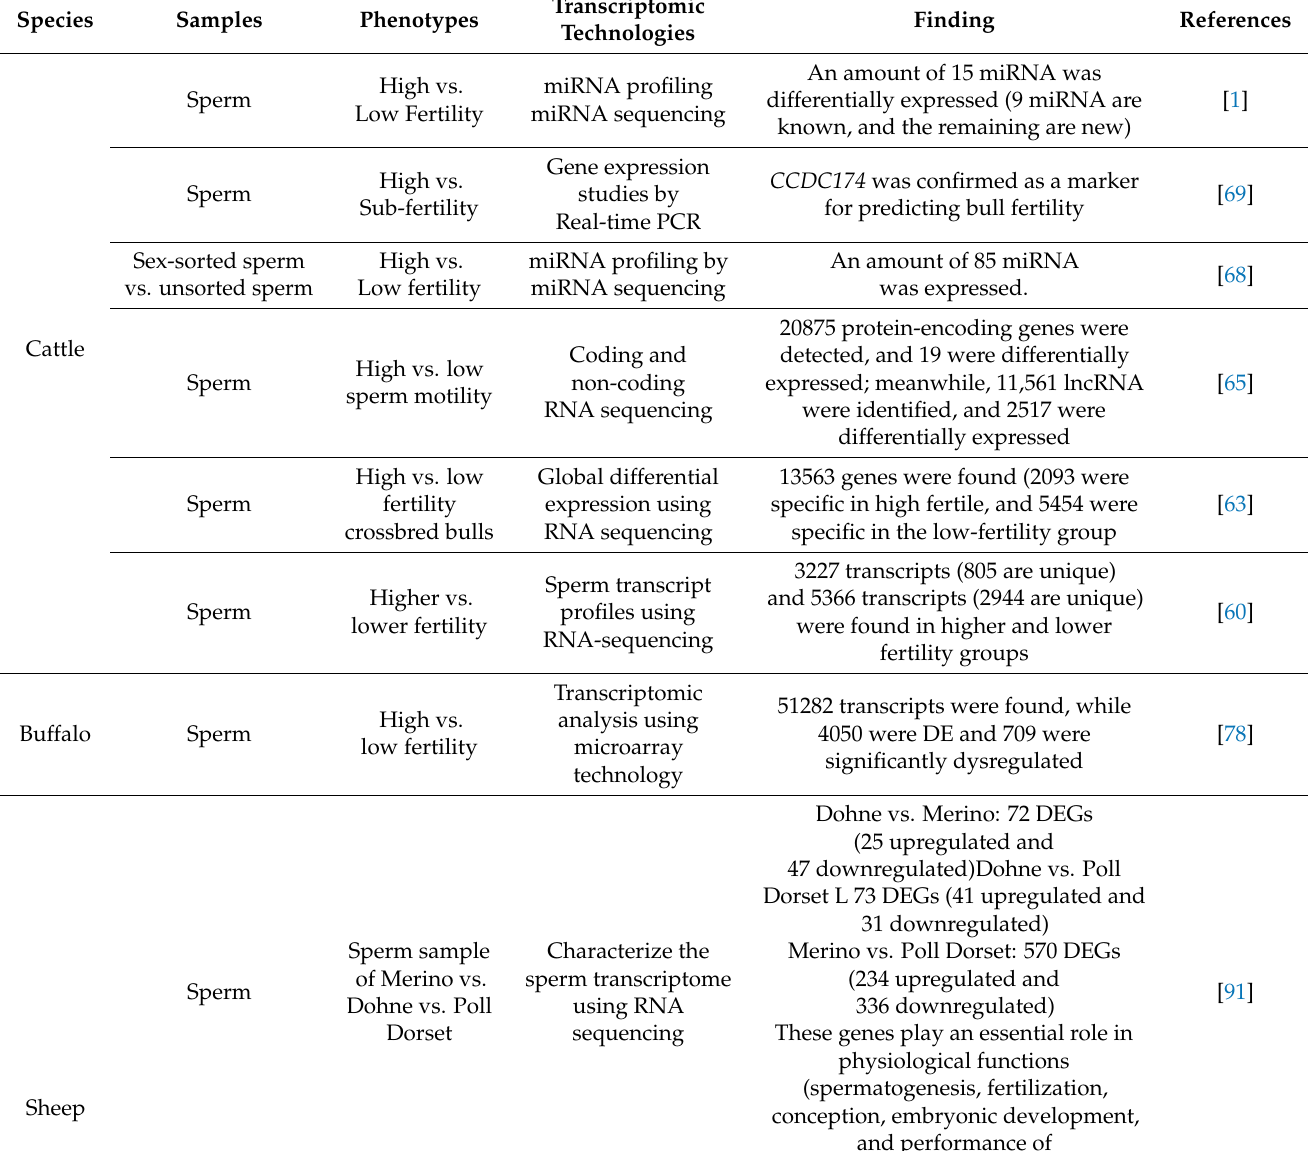
Table 2. The list of sperm transcriptome analyses of reproductive functions in various